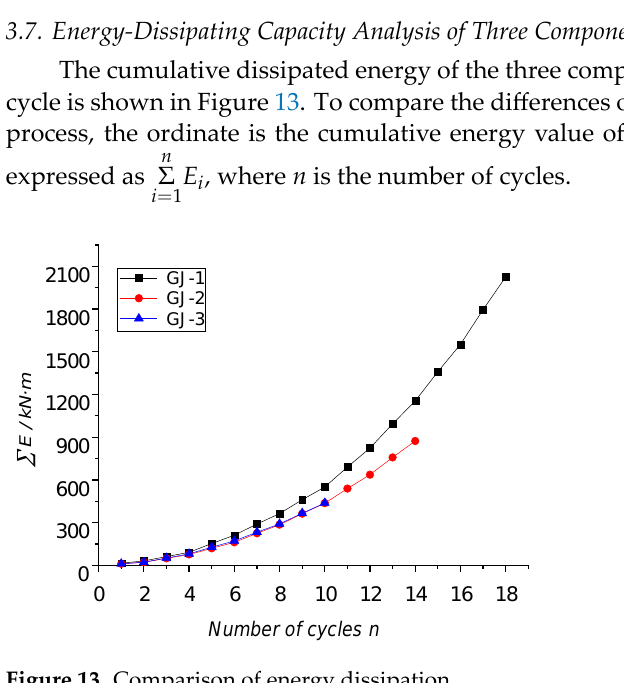
Figure 13. Comparison of energy dissipation.